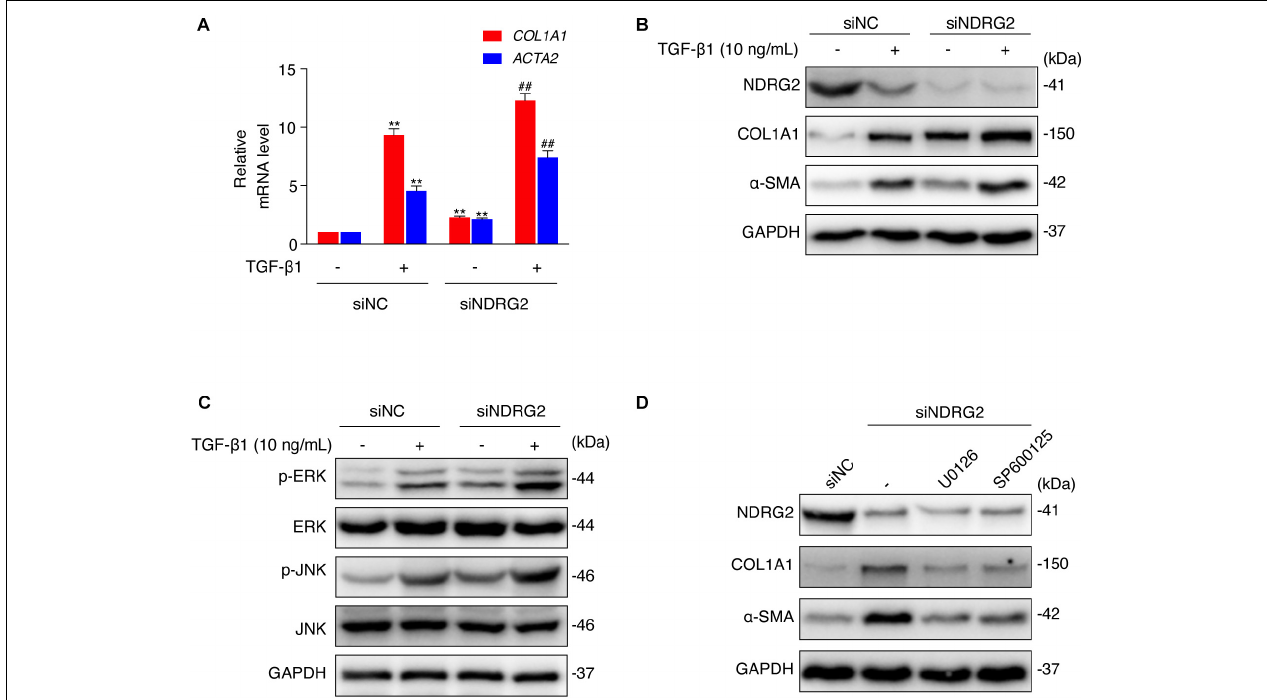
FIGURE 4 | Effects of NDRG2 on HSC activation and TGF- β 1/MAPK signaling pathway activity. (A) LX-2 cells were transfected with siNDRG2 or siNC for 24 h and stimulated with 10 ng/mL TGF- β 1 for another 24 h. Relative mRNA levels of ACTA2 and COL1A1 were analyzed by qRT-PCR. ** P < 0.01 compared with the control group; ## P < 0.01 compared with the TGF- β 1 treatment group, as analyzed by one-way ANOVA followed by Dunnett’s test. (B) The protein levels of α -SMA and COL1A1 were analyzed by western blotting. (C) LX-2 cells were treated as described above, except that the cells were stimulated with TGF- β 1 for 30 min, and the protein levels of total and phosphorylated JNK and ERK1/2 were analyzed by western blotting. (D) LX-2 cells were transfected with siNDRG2 and siNC for 24 h, treated with the ERK inhibitor U0126 (10 µ M) or the JNK inhibitor SP600125 (50 µ M) for 2 h. The protein levels of α -SMA and COL1A1 were analyzed by western